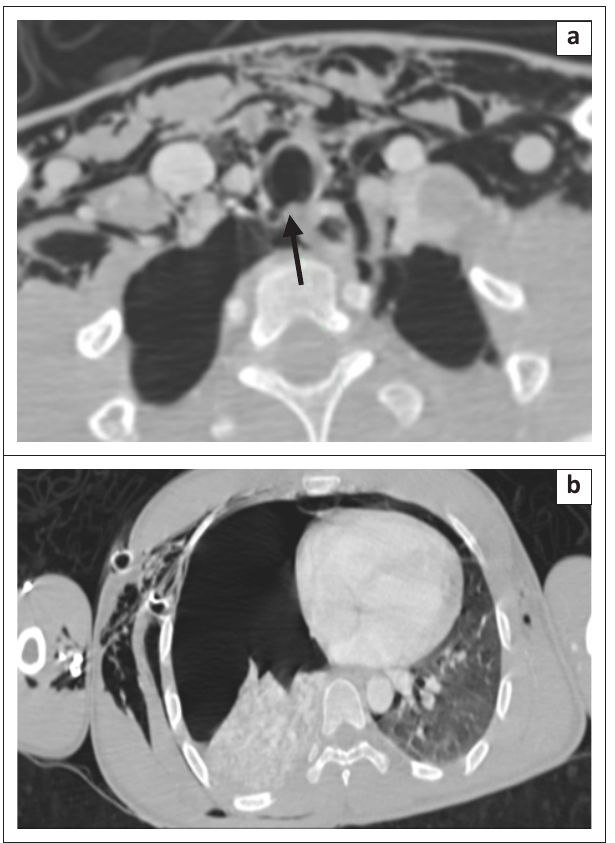
FIGURE 8: (a) Demonstrates extensive cervical surgical emphysema with a tracheal defect at the 7 o’clock position (arrow). A right-sided tension pneumothorax is also present with mediastinal shift to the left